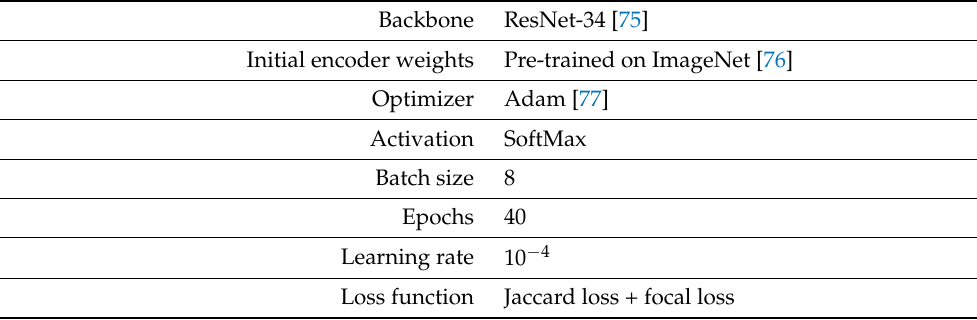
Table 1. Implementation details for U-Net and Panoptic FPN.